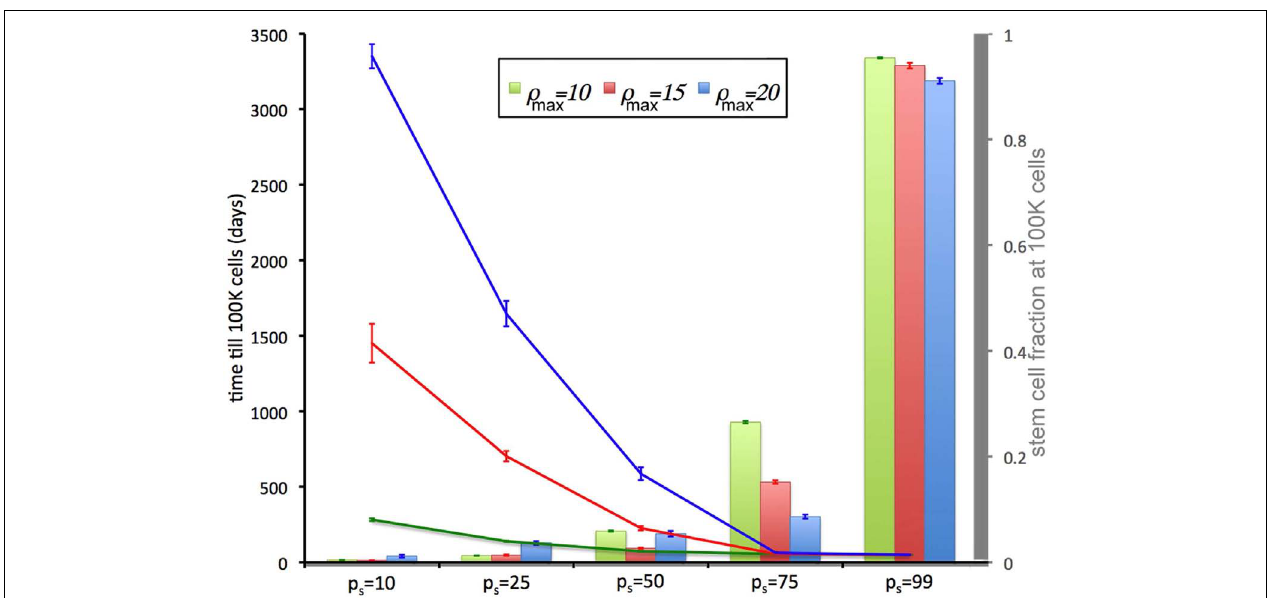
proliferation capacity ρ , but for larger p s the trend reverses. For p s = 50% there is a U -shape dependence on ρ max . For p s ≤ 75%, the stem cell fraction is substantially less than the symmetric division probability p s . For p